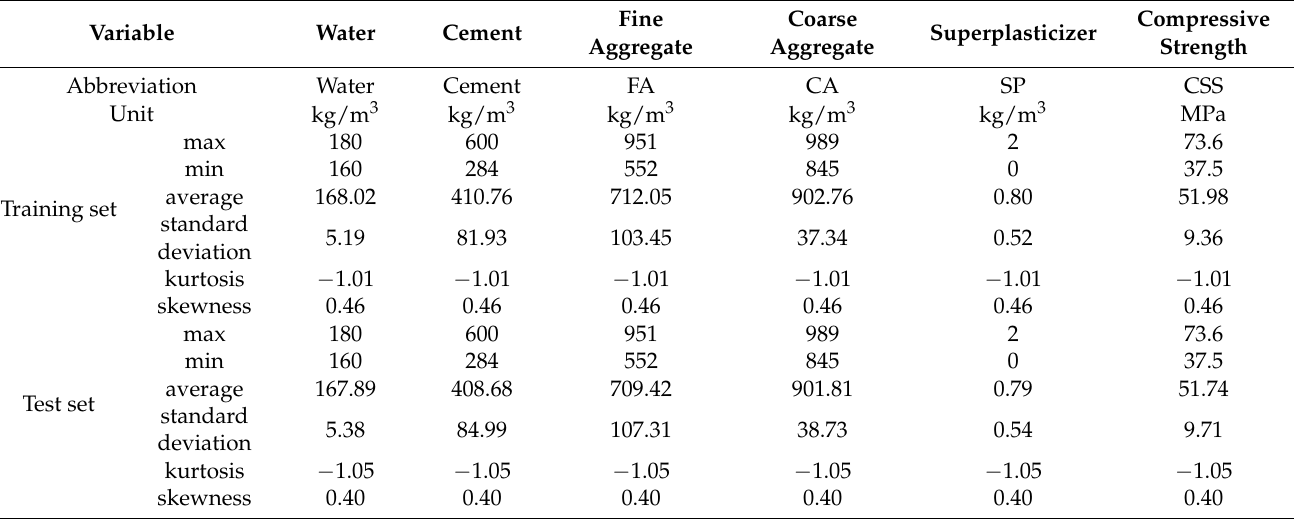
Figure 3. Correlation coefficients and distribution of data variables. Table 1. Statistical characteristics of input and output